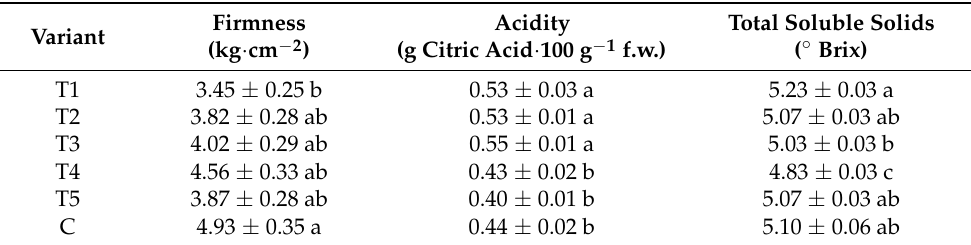
Table 4. The organoleptic properties of tomato fruits under the influence of different electric current treatments.